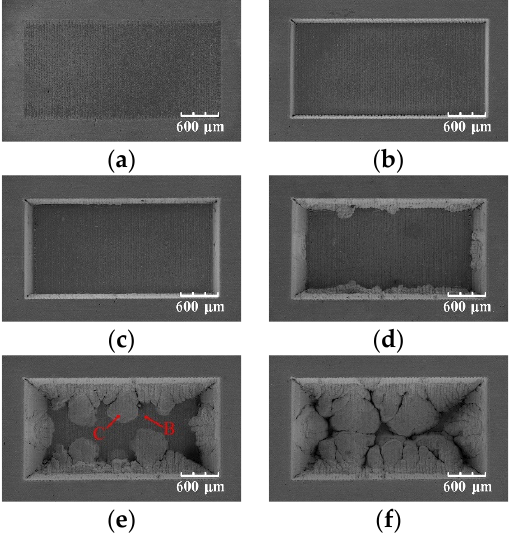
Figure 5. SEM of workpieces processed a different number of times by conventional laser processing after cleaning: ( a ) 1 time, ( b ) 50 times, ( c ) 100 times, ( d ) 200 times, ( e ) 300 times, ( f ) 400 times, B in ( e ) was the surface of normal machining, C in ( e ) was the surface of deposit.